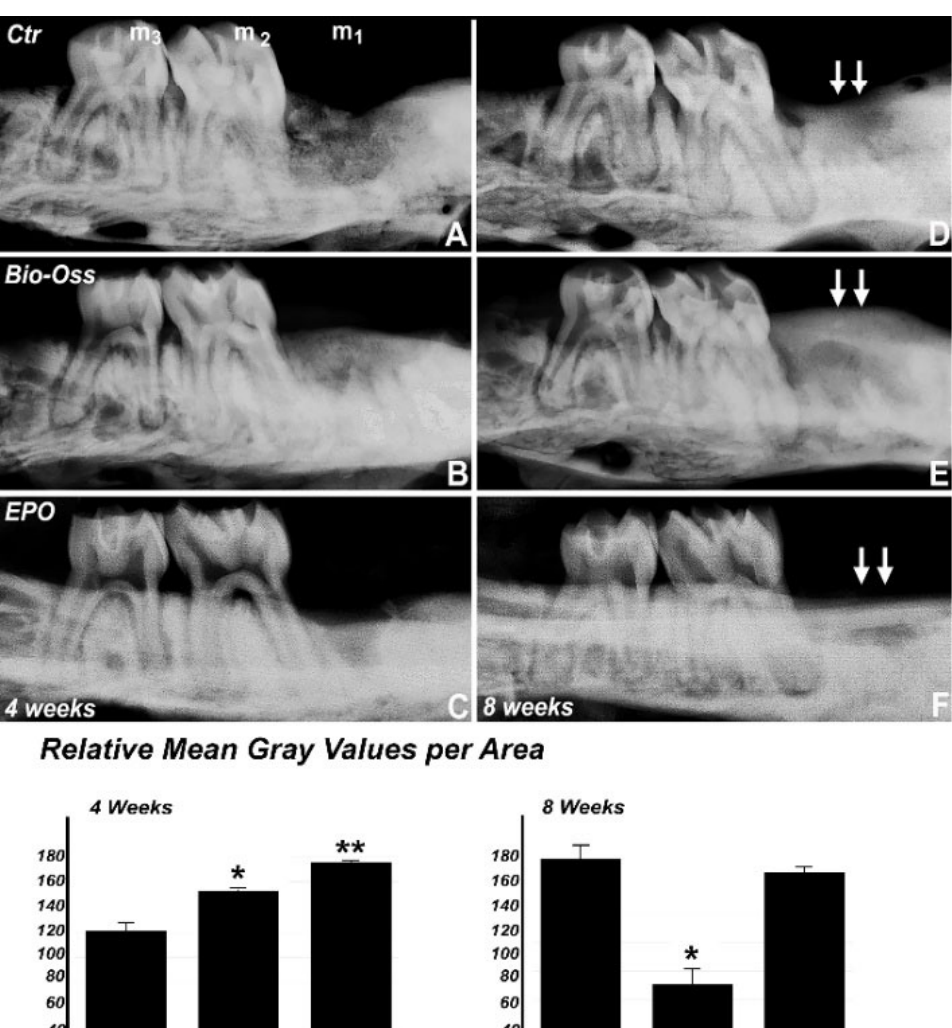
ber of blood vessels per area using histomorphometry. Blood vessel counts were performed by comparing representative trichrome stained micrographs for all groups (Figure 3C,E) using ImageJ software. The number of blood vessels in the newly mineralized area were similar in the control and EPO group while they were significantly lower in the Bio-Oss group (Figure 3D). High magnification micrographs of eight weeks post-surgery alveolar regeneration sites demonstrated the close proximity between the blood vessels and the new ossification sites as revealed by von Kossa staining (Figure 3E,F, arrows).